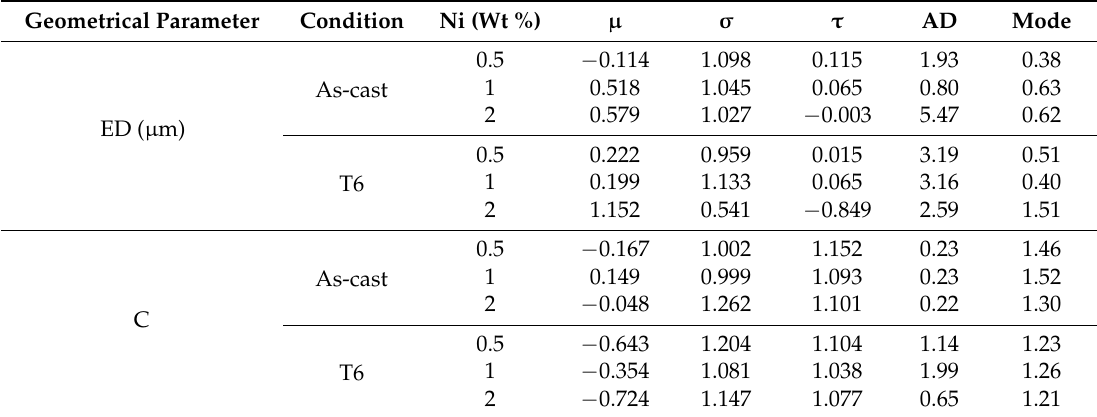
Figure 6. PDF for parameters of eutectic Si particles: ( a ) ED; and ( b ) C. Table 3. Parameters of the lognormal distributions for ED and C of Ni-based intermetallic compounds for the three investigated alloys, in both as-cast and T6